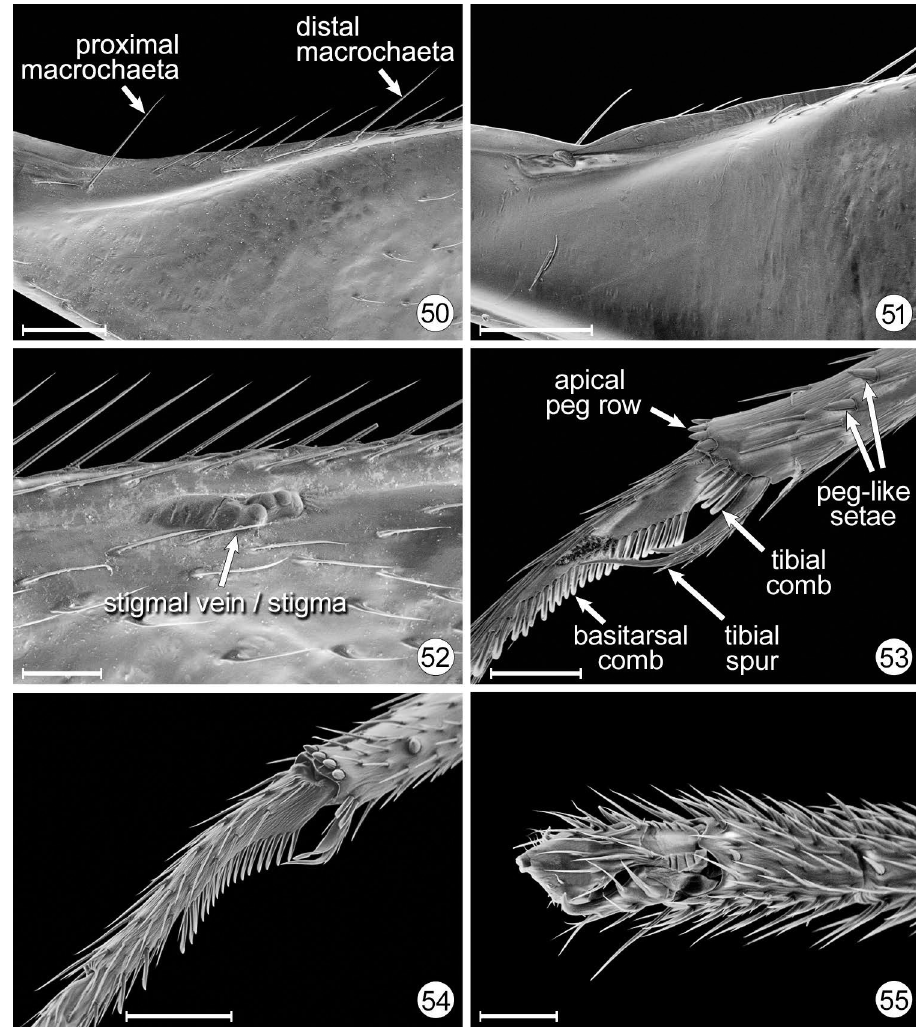
Figures 50–55. Neotriadomerus spp. 50 N. darlingi male parastigma, dorsal 51 N. longissimus female parastigma, ventral 52 N. darlingi male stigmal vein, dorsal 53 N. longissimus female calcar, lateral 54 N. sp. female calcar, dorsolateral 55 N. sp. female pretarsus, dorsolateral. Scale bar for 50, 53, 54 = 50 μm; 51 = 100 μm; 52, 55 = 20